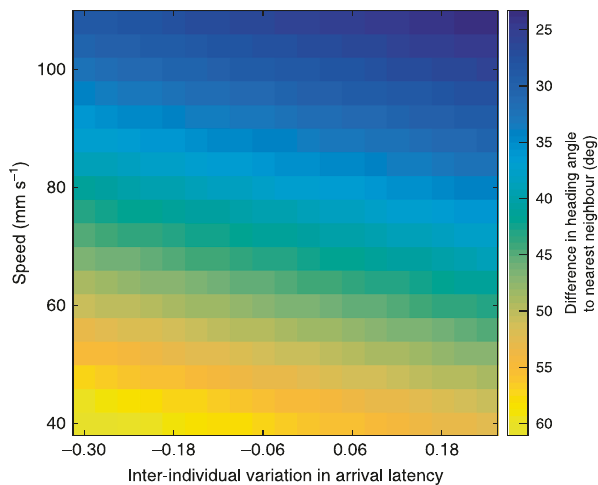
Fig. 4 Individuals that are consistently faster to arrive at the stimulus maintain larger differences in the heading angle to their nearest neighbour outside of the foraging context. Heat map to show the relationship between the predicted difference in heading angle of individuals to their nearest neighbour as a function of inter-individual variation in arrival latency and swimming speed. Predictions are generated within the observed range for each parameter from a LMM with the mean heading difference to the nearest neighbour (averaged over every frame in the three minutes prior to the stimulus presentations) as the response variable, and the individual identity intercepts from a model of latency to arrive at the stimulus (Supplementary Table 6, excluding arrival order) and mean speed (averaged over every frame in the three minutes prior to the stimulus presentations) as main effects. The heat shows that within the observed range of mean swimming speeds, the heading difference of individuals to their nearest neighbour is larger for individuals that arrive consistently sooner at the stimulus (more negative